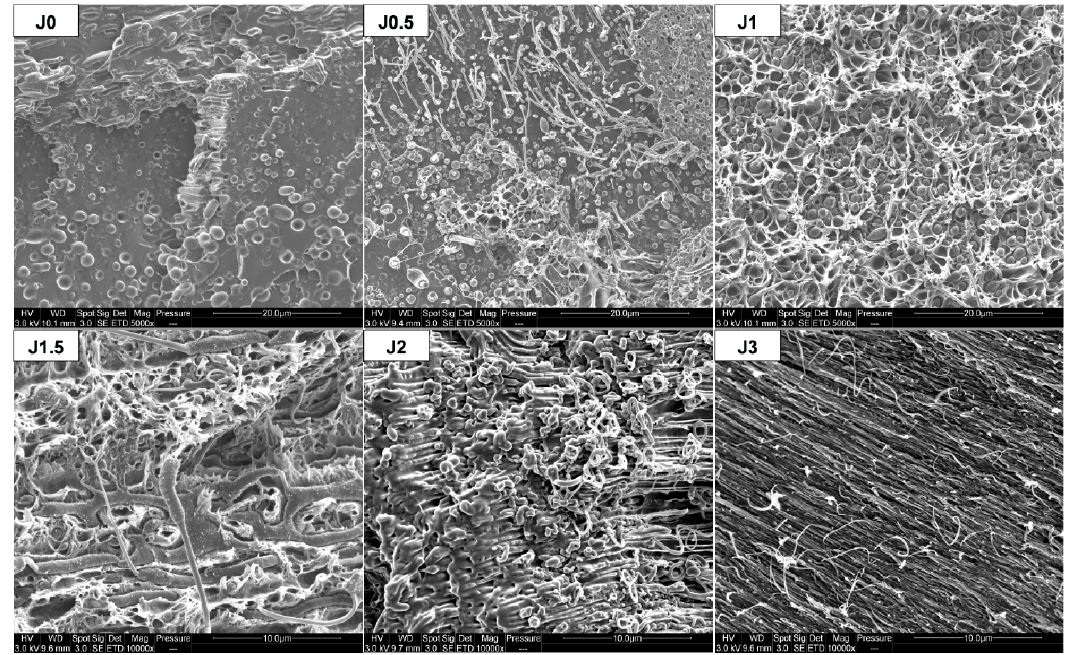
Figure 11. SEM observations of tensile fracture surface for printed samples.